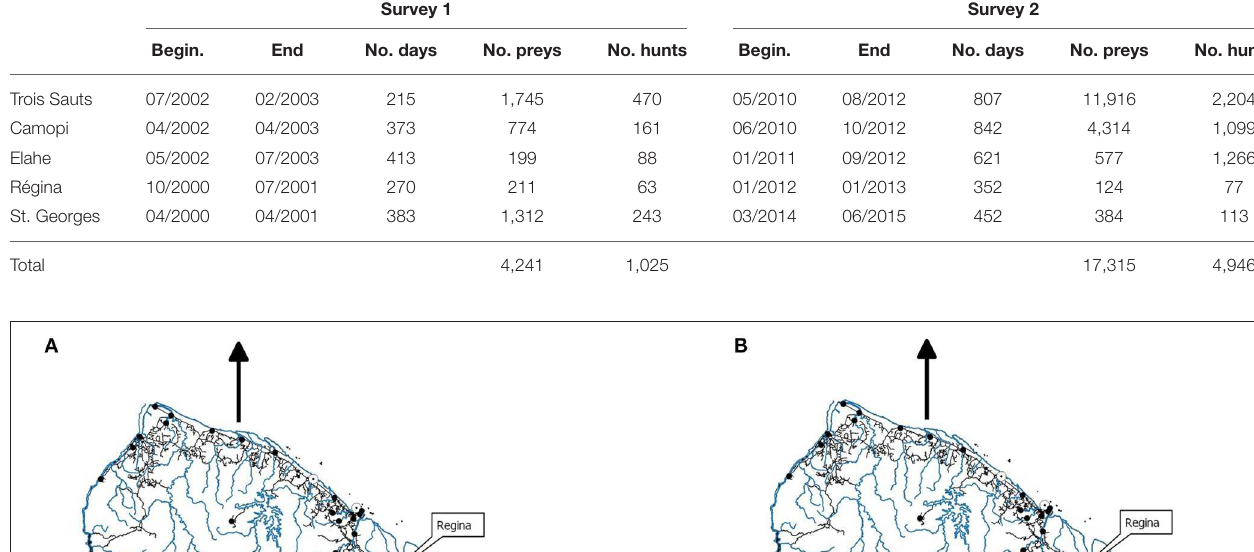
TABLE 1 | Characteristics of the two hunting surveys conducted in French Guiana. Survey 1 Survey 2